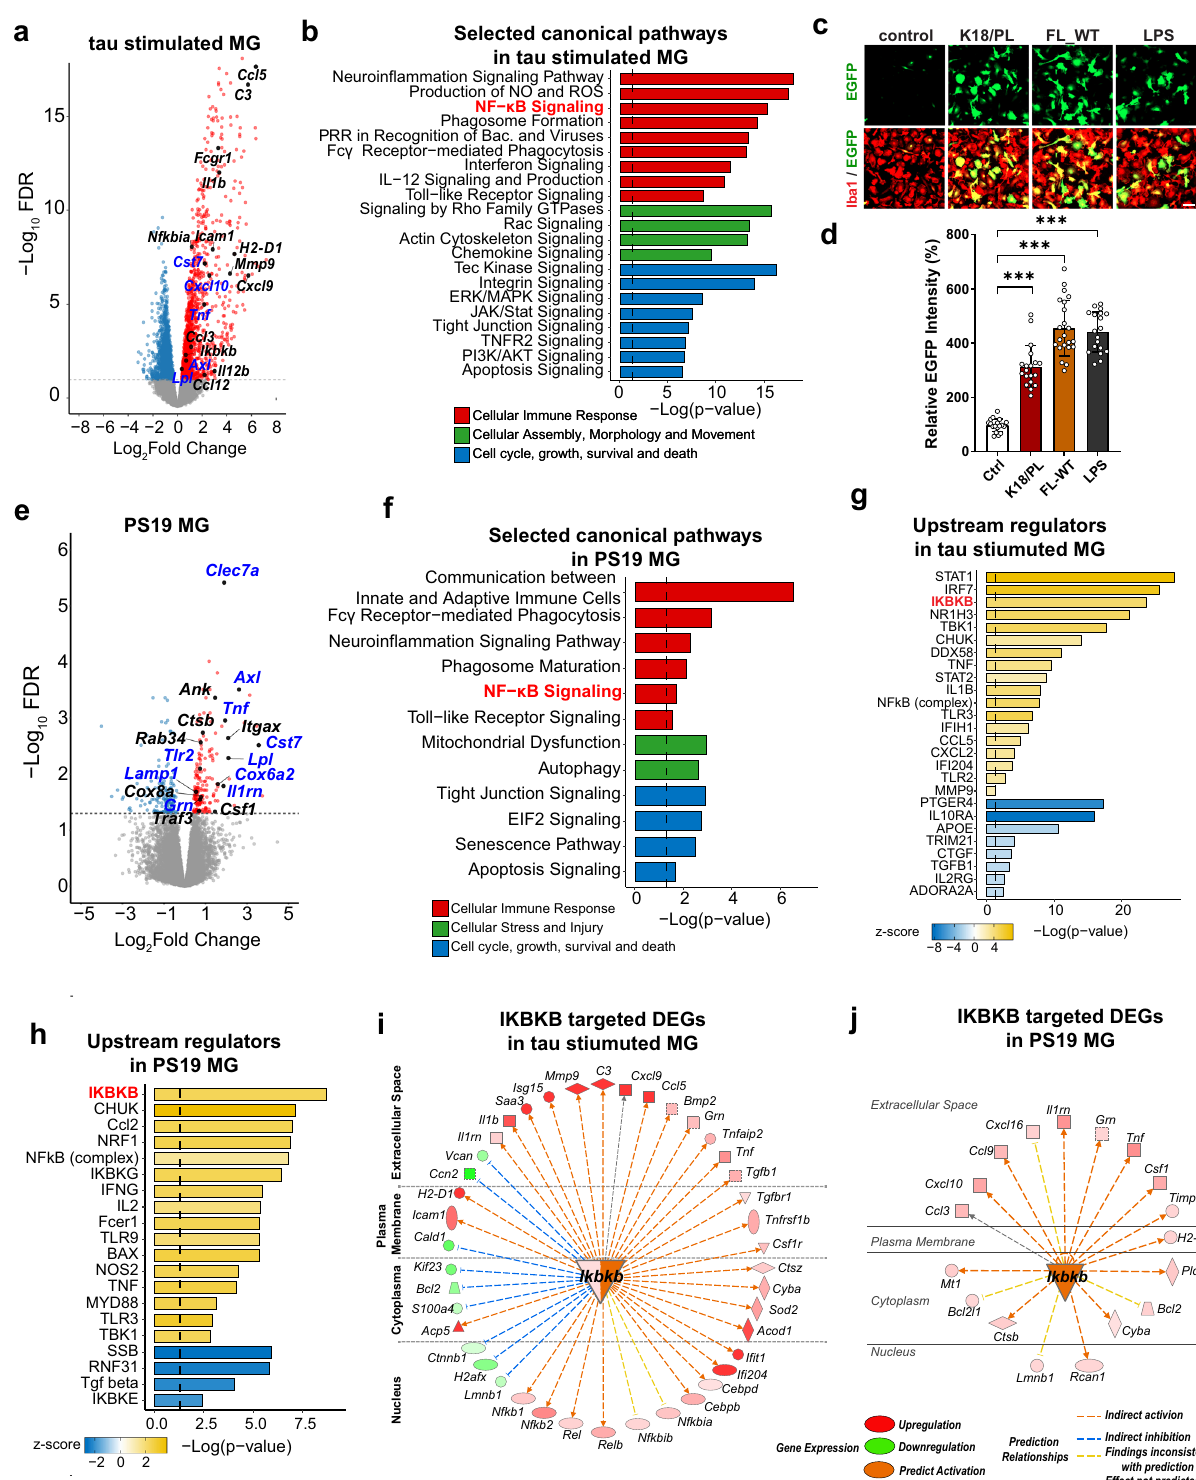
PS19 microglia (Supplementary Fig. 1c, d). Speci fi cally, I κ B kinase complex subunit IKK β ( Ikbkb ) was identi fi ed as one of the top upstream regulators responsible for tau-mediated transcriptomic changes in primary microglia (Fig. 1g) and PS19 microglia (Fig. 1h) using IPA upstream regulatory analysis 36 . Ikbkb gene itself was also upregulated in tau-stimulated microglia, and predicted to be activated in PS19 microglia (Fig. 1i, j). Indeed, a NATURE COMMUNICATIONS| (2022) 13:1969